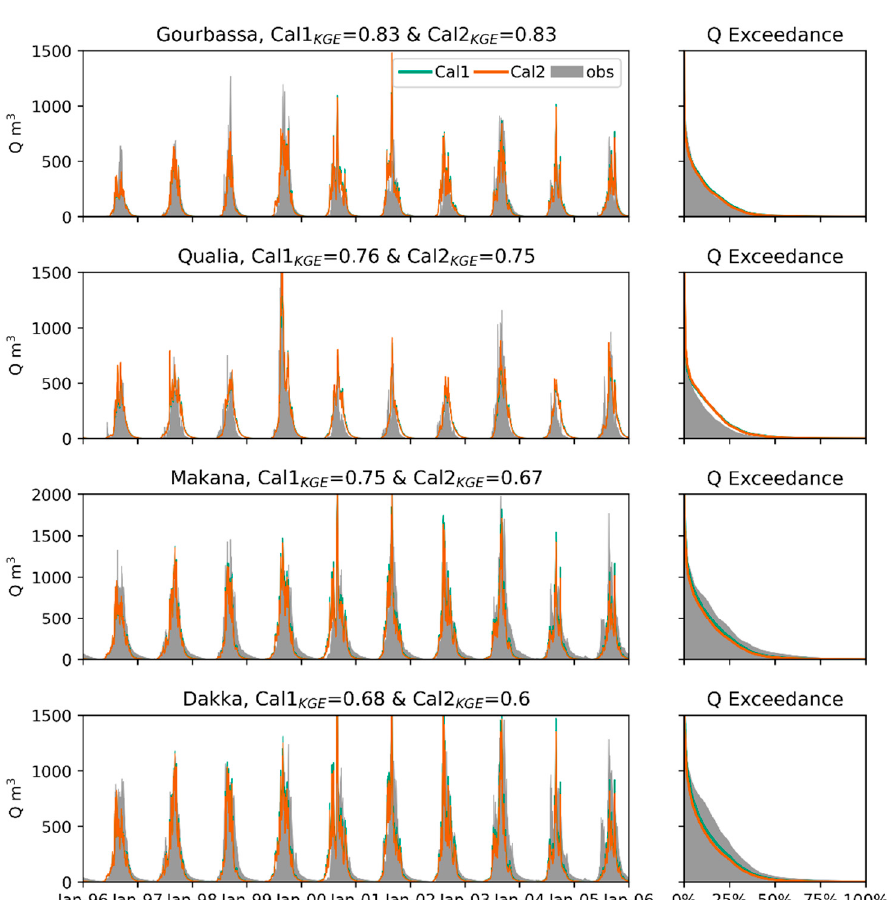
Figure 10. Simulation results of the featured runs of Cal1 and Cal2. Discharge is evaluated for the entire 10-year simulation period at the 4 stations used in calibration. The KGE scores are given in the title of each panel. The left panel shows timeseries based on daily values and the right panel shows the flow duration curves.